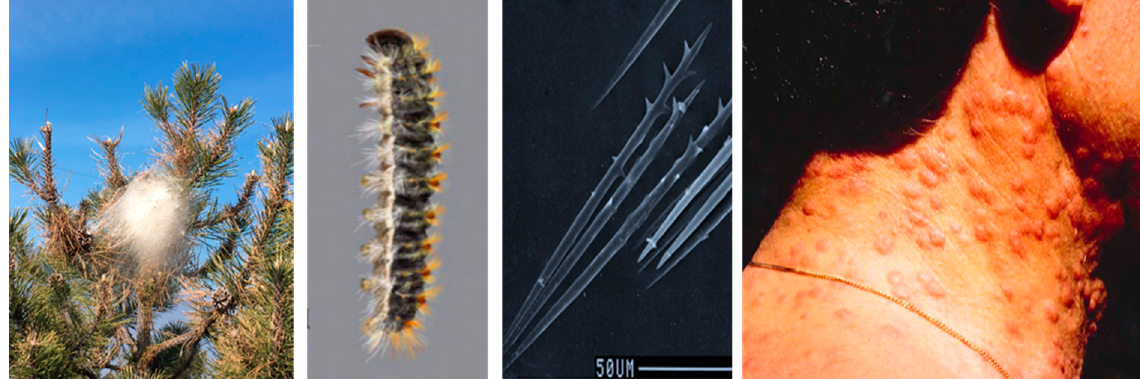
Figure 1. Pine tree ( Pinus nigra ) with a nest of the pine processionary moth, mature larva with the integument folds containing urticating setae on the back, urticating setae, pine processionary moth cutaneous reactions. Photographs by A. Battisti.